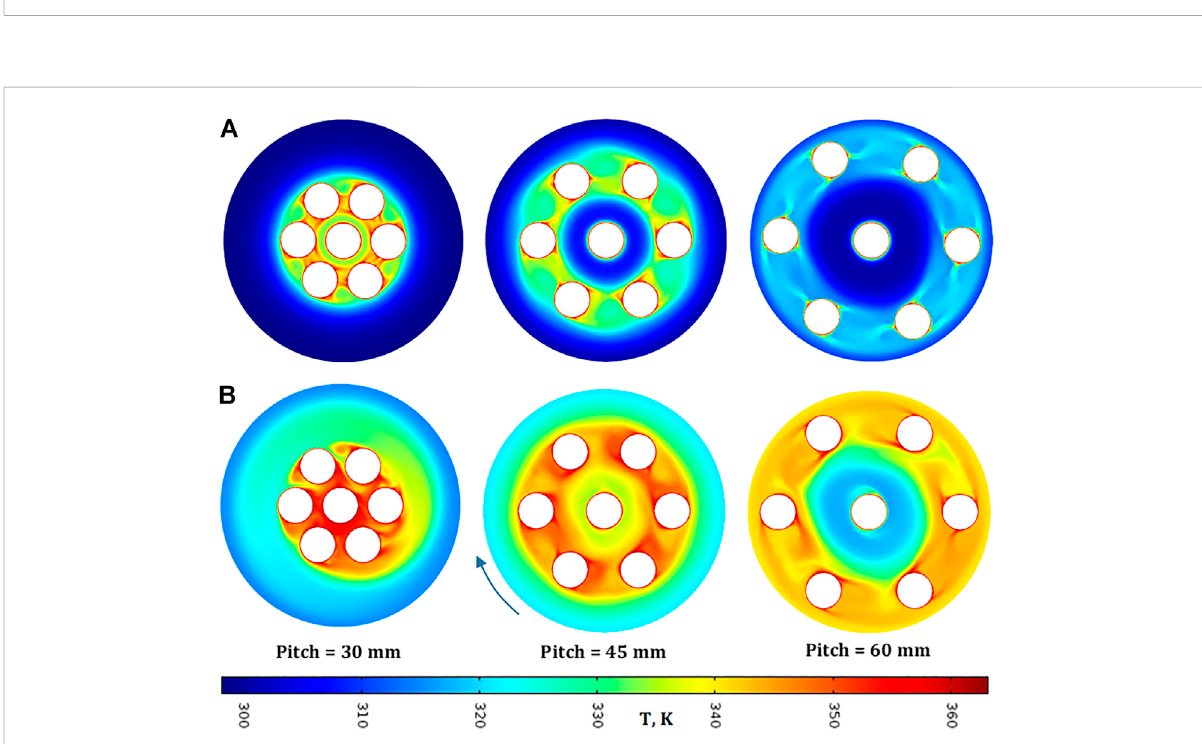
FIGURE 5 Temperature pro fi les at (A) 1s and (B) 5 s for different pitch values in adiabatic conditions in uniform con fi guration. Fluid: water, T spot = 90 ° C, T ext = 25 °